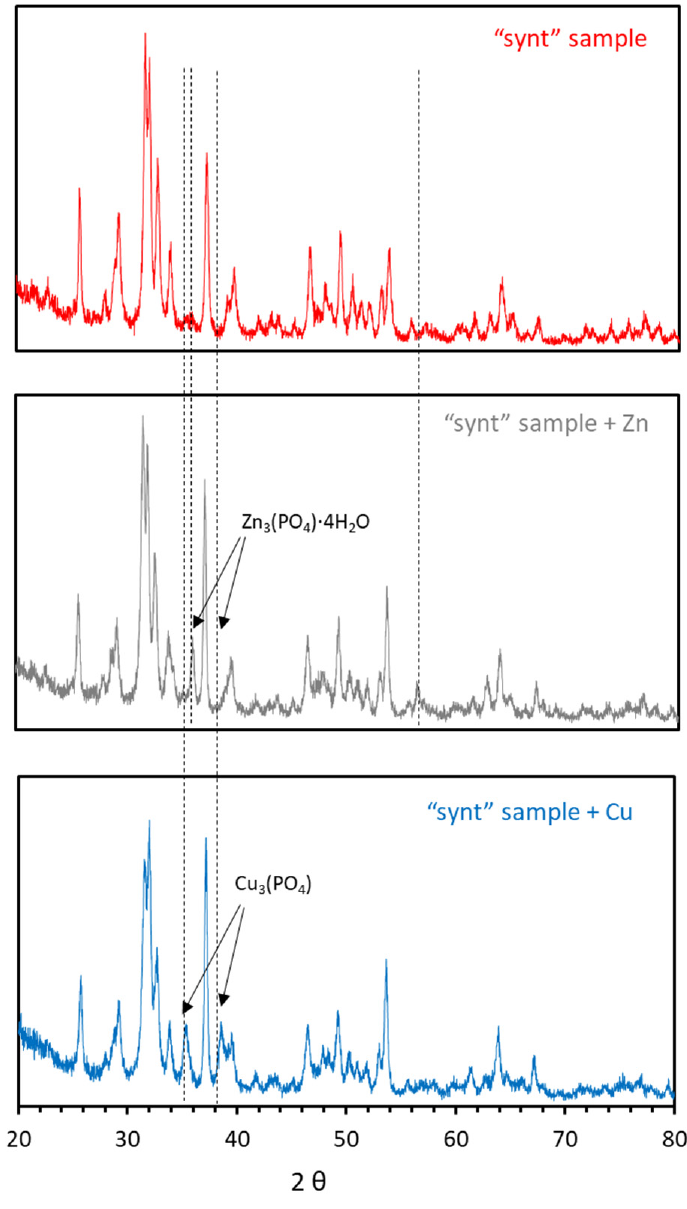
Figure 10. XRD patterns of the synthesized material after contact with Zn and Cu.